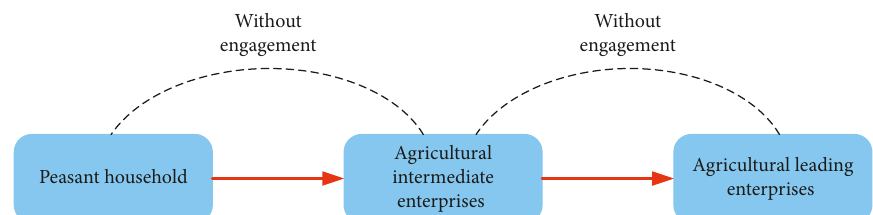
Figure 3: Schematic diagram of the construction of market trading agricultural industry